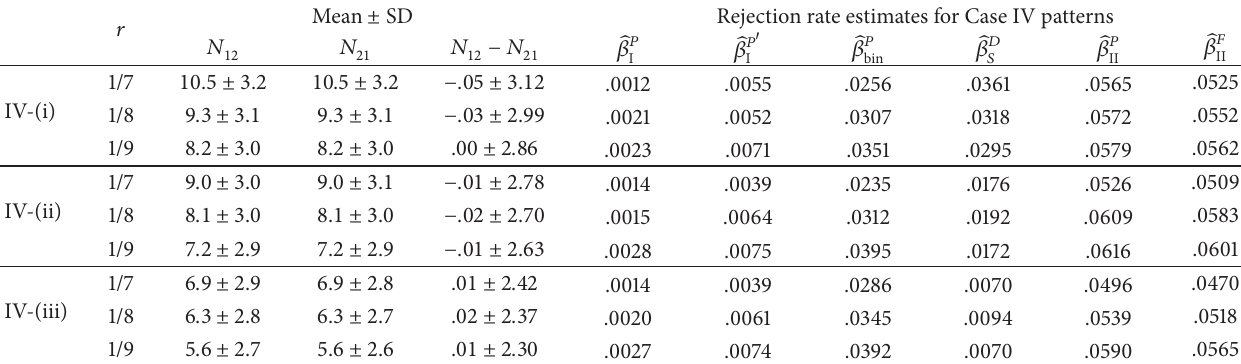
Table 10: The means ( ± SD) of the off-diagonal entries, 𝑁 12 , 𝑁 21 , and their difference 𝑁 12 − 𝑁 21 and the rejection rate estimates for Case IV = 10000 , 𝑛 = 𝑛 = 40 at 𝛼 = .05 . The rejection rate labeling and superscripting for “ < ” and “ > ” are as in Table 6. patterns with 𝑁 1 2 mc 𝑟